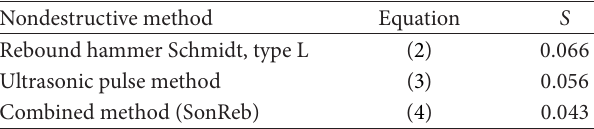
Table 2: Residual standard deviation of relationships for prediction of compressive strength of calcium silicate bricks.